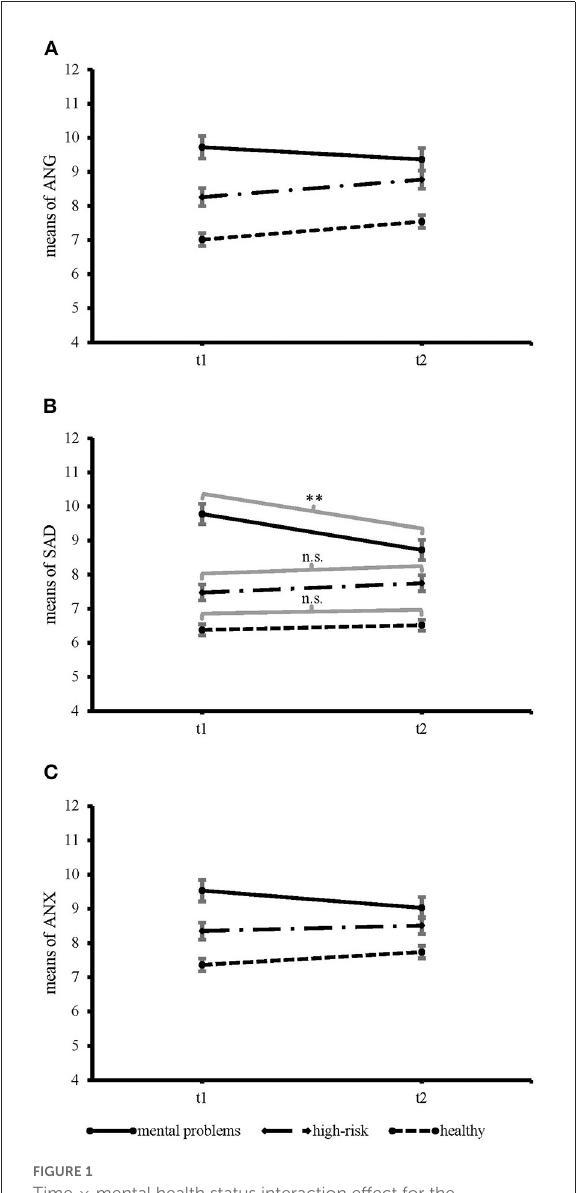
FIGURE1 Time × mental health status interaction effect for the psychological symptom subscales. (A) anger, F (2,968) = 1.87 , p = 0.155 , (B) sadness, F (2,970) = 4.28 , p = 0.014 , and (C) anxiety, F (2,968) = 2.01 , p = 0.135 . Error bars mark the standard error of the mean. The possible range of values was between 4 and 12. ** p < 0.01